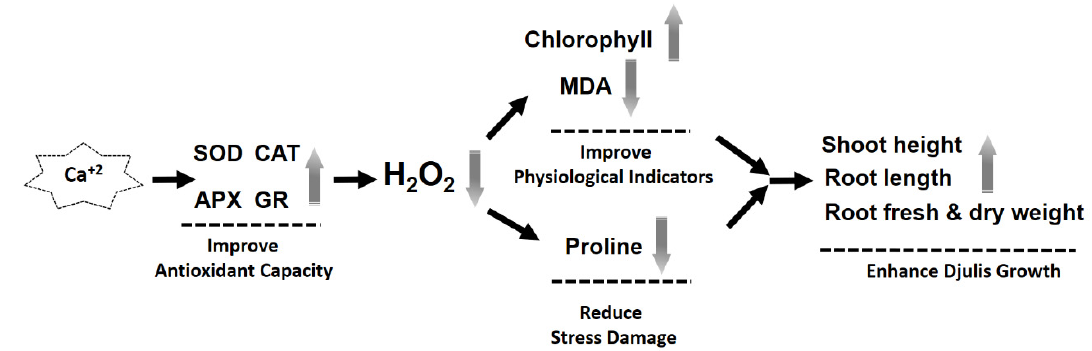
Figure 7. Mechanism diagram of calcium carbonate to promote the growth of djulis sprouts.